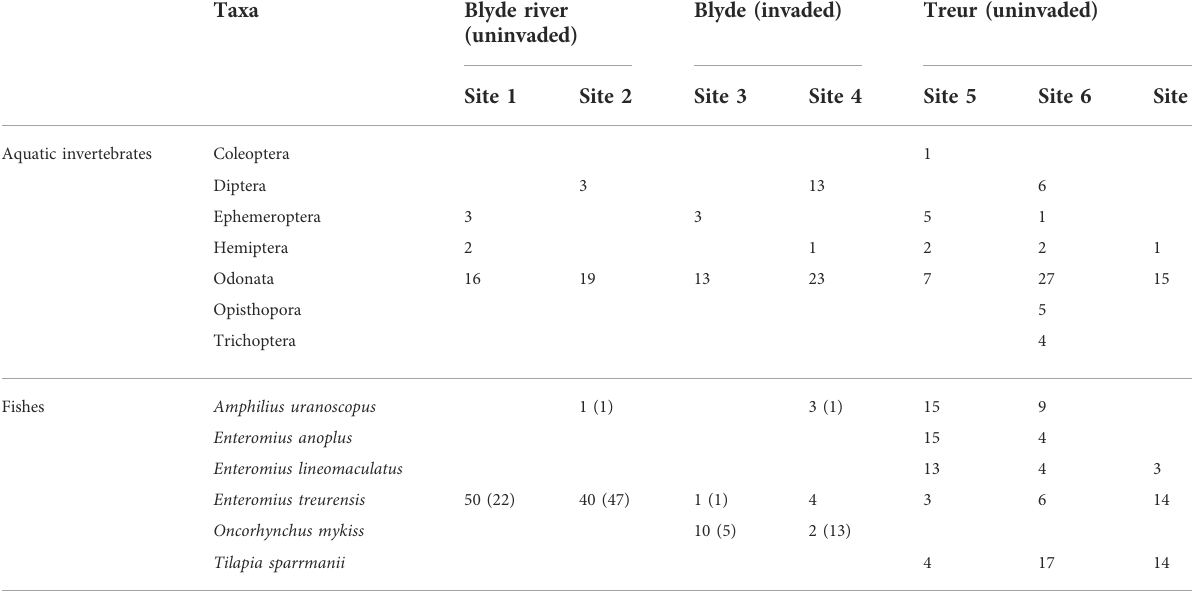
TABLE 2 The composition and abundance (by numbers) of invertebrate and fi sh taxa sampled from sites invaded by rainbow trout ( Oncorhynchus mykiss ) on the Blyde River and sites free of invasion both the Blyde River and Treur rivers. The numbers of fi sh outside parentheses indicate the total number of individuals collected using electro fi shing and those in parentheses using fyke